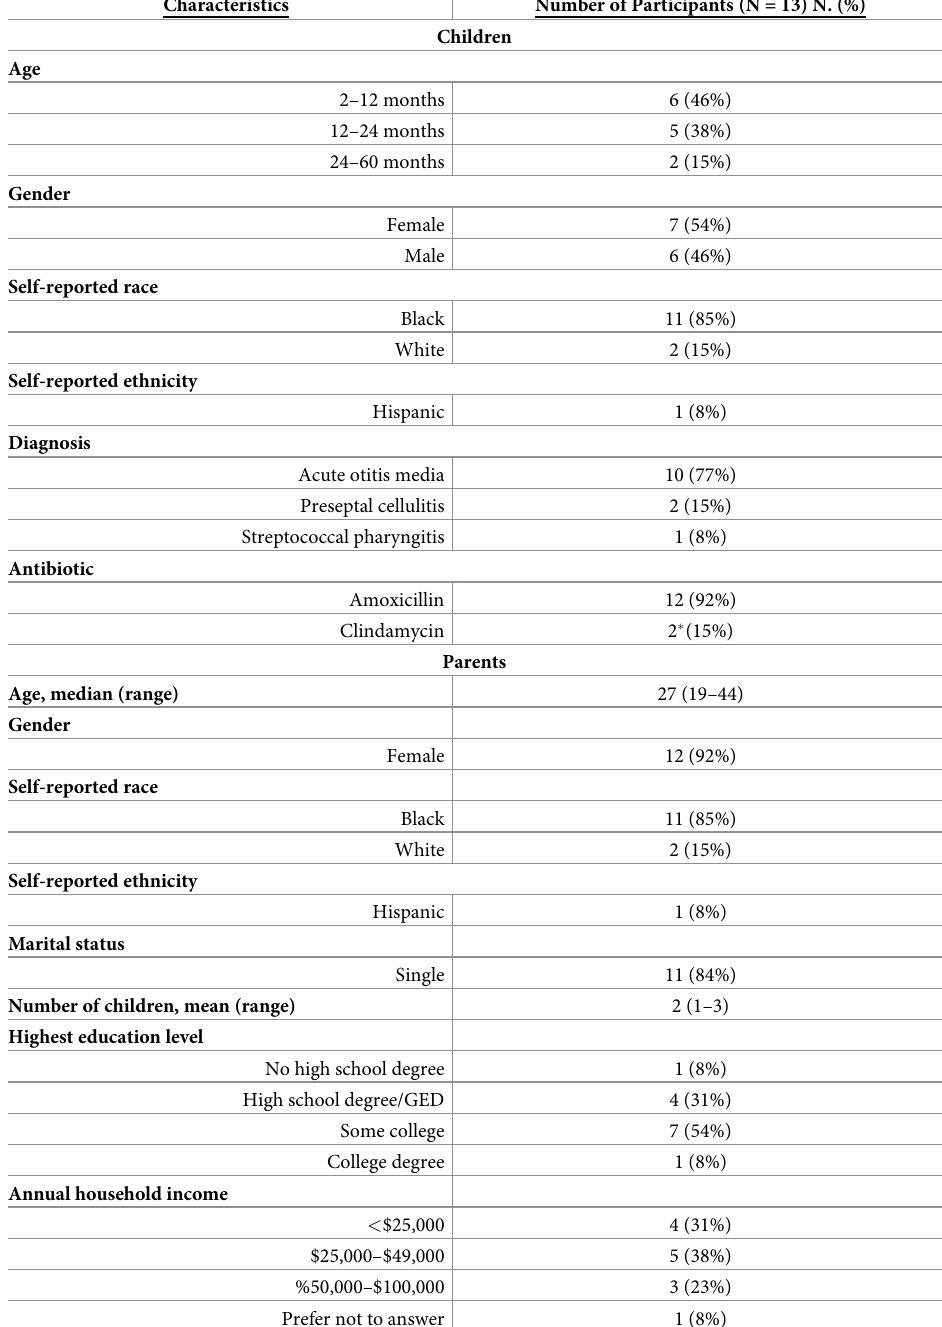
Table 1. Sociodemographic characteristics of participants (N = 13 parent-child